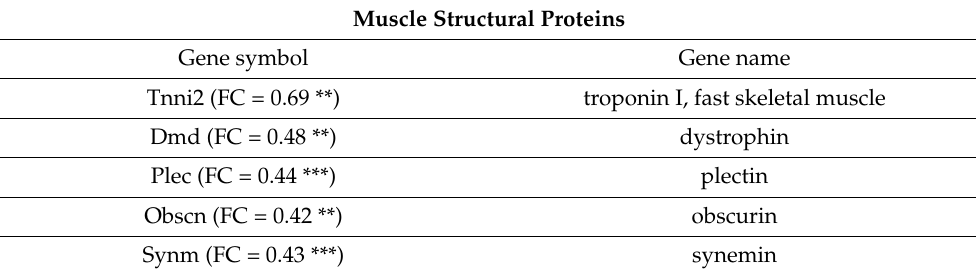
Table 4. Proteins identified from functional enrichment (ToppFun) analysis of downregulated muscle structural proteins (Table S2) in the EV-treated hindlimb. Fold-change (FC) and p -values are shown for each